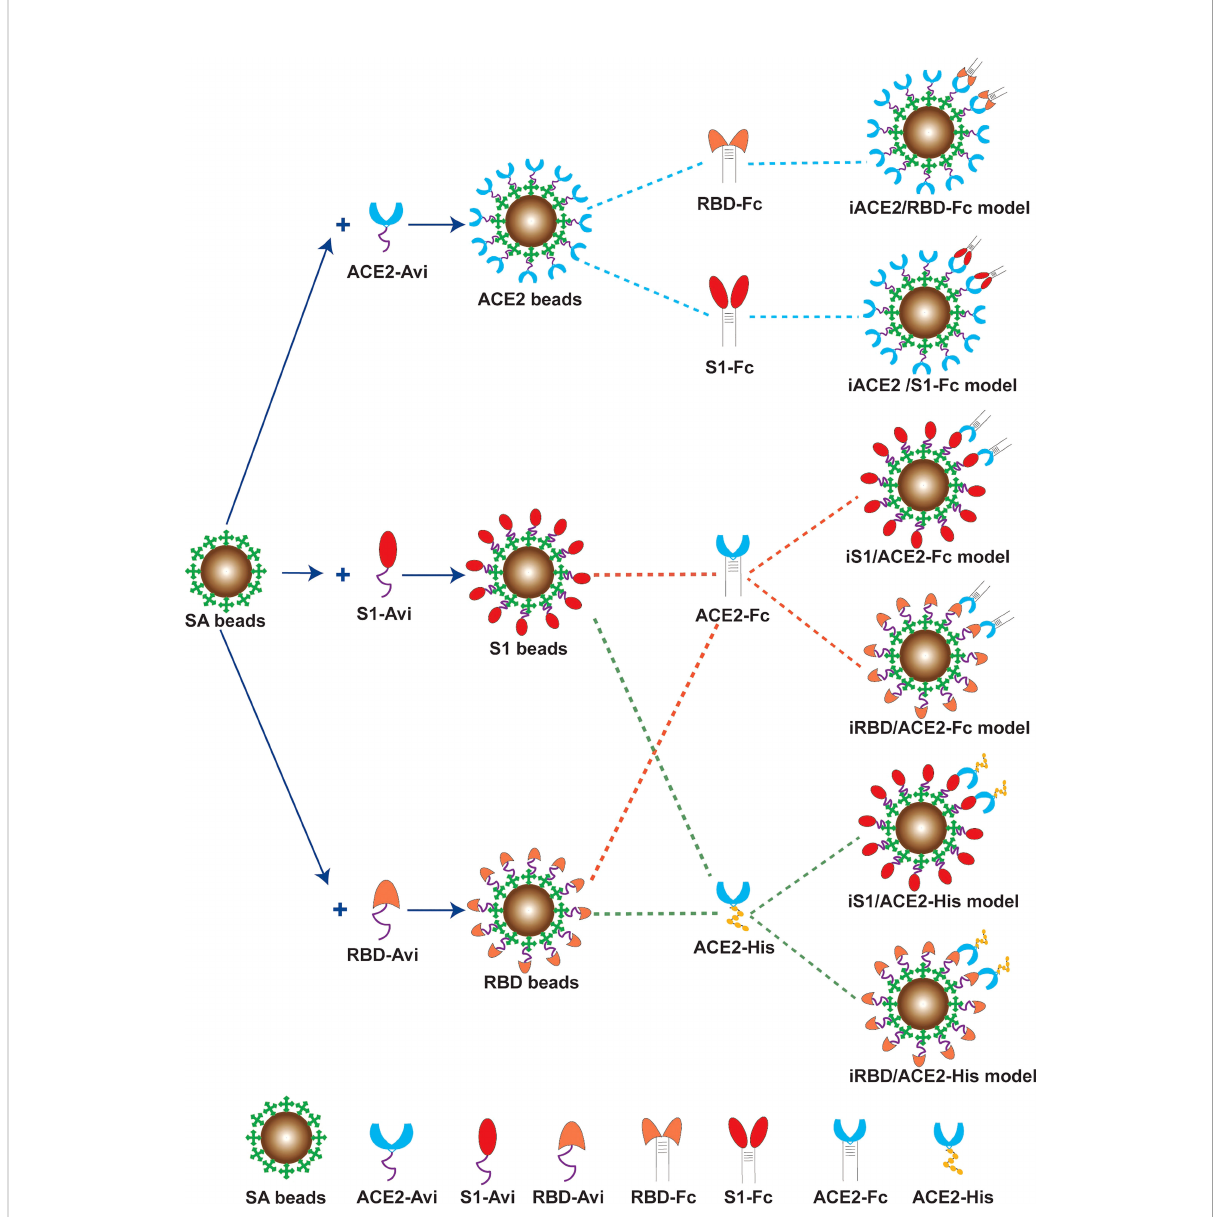
FIGURE 1 Schematic diagram of the six BFNT models to detect SARS-CoV-2 nAb. Streptavdin coated magnetic bead (SA bead) was immobilized by recombinant human ACE2 protein with a biotinylated Avi tag (ACE2-Avi), recombinant SARS-CoV-2 Spike S1 protein with a biotinylated Avi tag (S1-Avi) and recombinant SARS-CoV-2 spike RBD protein with a biotinylated Avi tag (RBD-Avi) to generate ACE2 bead, S1 bead and RBD bead, respectively. The ACE2 bead with a soluble RBD-Fc or S1-Fc protein were combined to establish iACE2/RBD-Fc or iACE2/S1-Fc model. The RBD bead or the S1 bead was combined with a ACE2-Fc or ACE2-His protein to establish iRBD/ACE2-Fc, iS1/ACE2-Fc, iRBD/ACE2-His or iS1/ ACE2-His